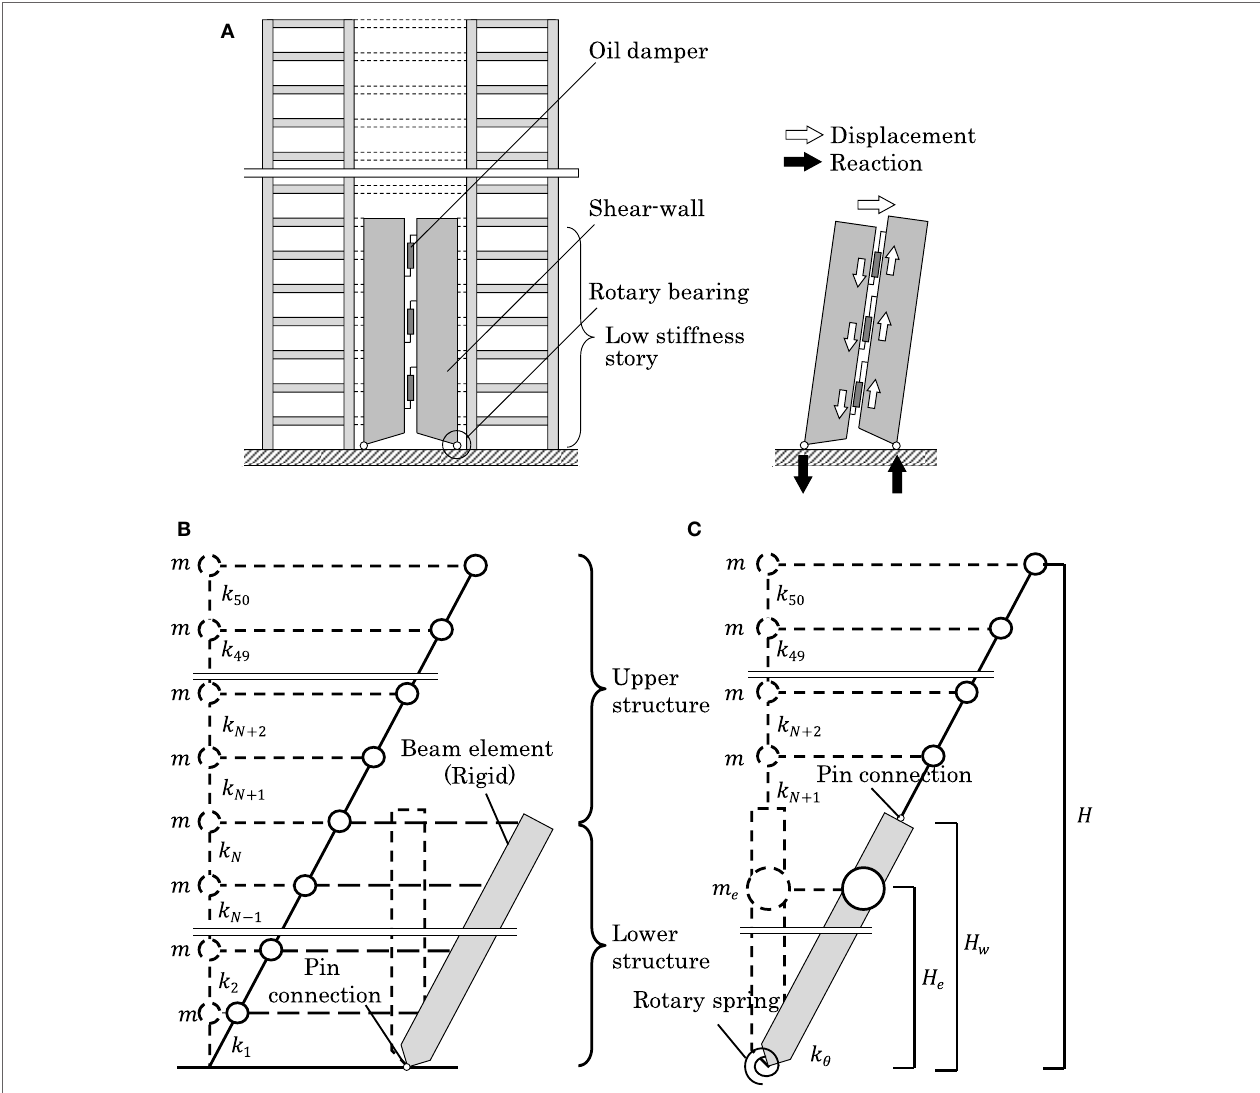
FIGURE 1 | Proposed vibration-controlled structure and its modeling into multi-degree-of-freedom model and reduced model: (A) proposed system, (B) MDOF model, and (C) reduced